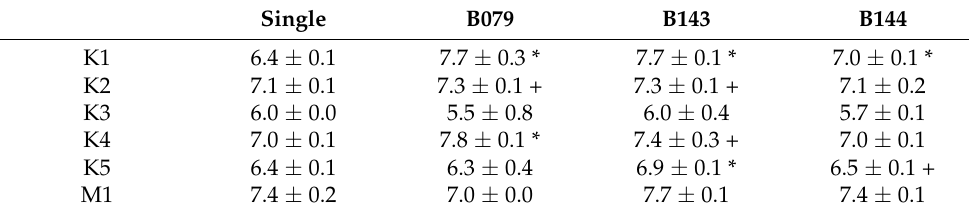
Table 5. Ethanol content (%) the end of Kveik + NCY co-fermentations.